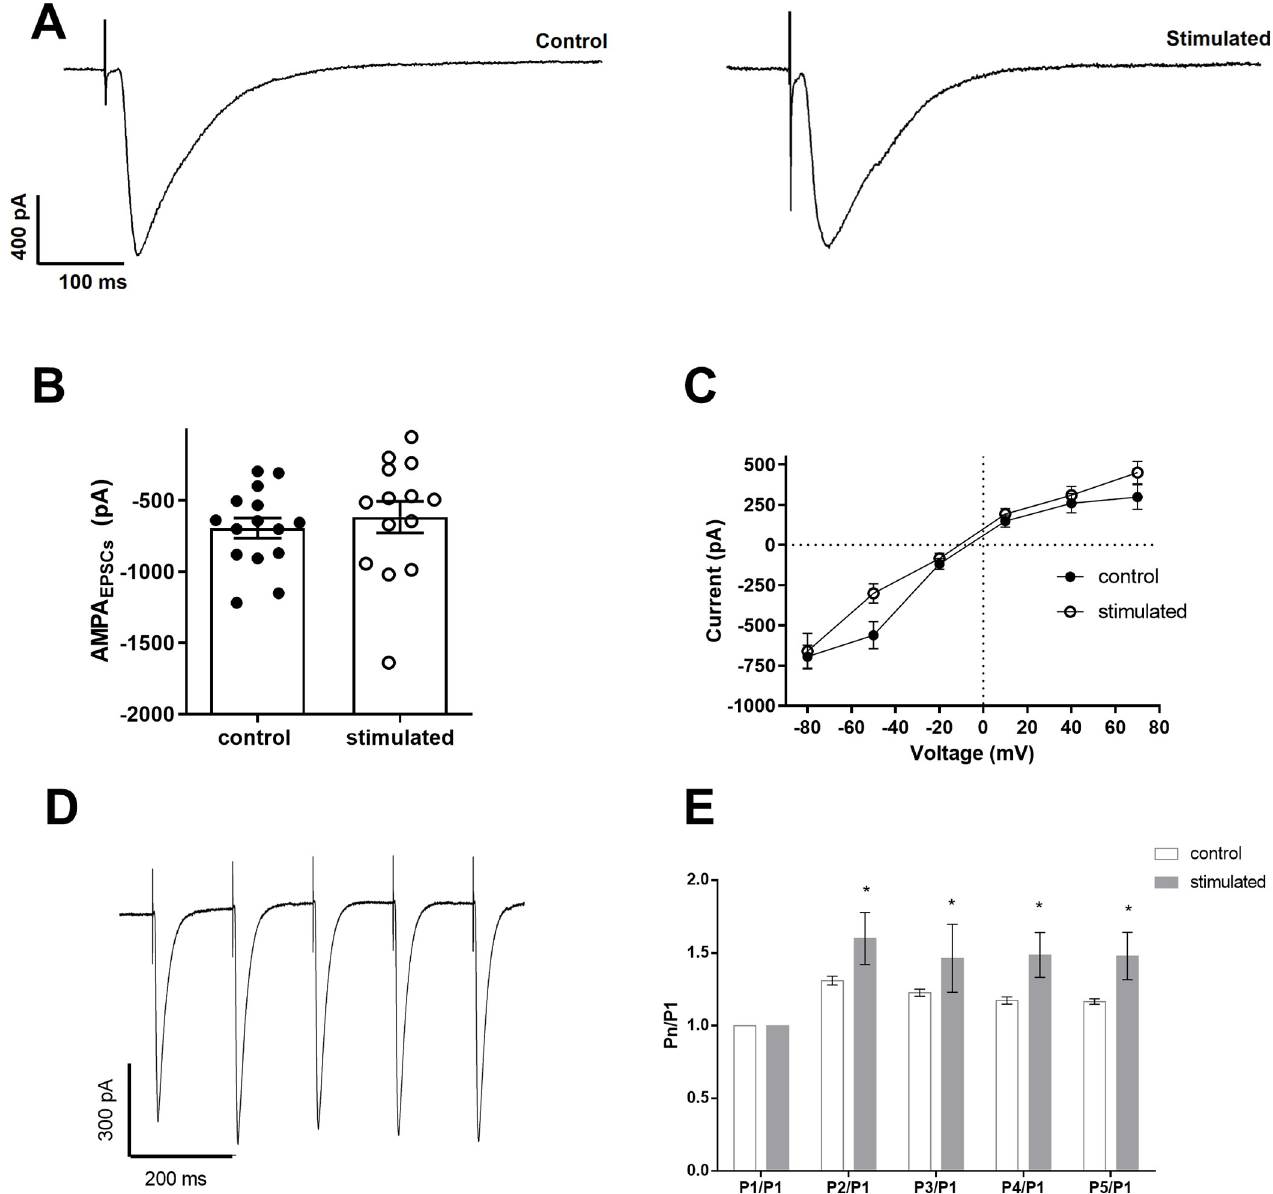
Fig 1. Evoked excitatory AMPA/KA post-synaptic currents (EPSCs) in CA1 pyramidal cells. A. EPSCs recorded in the presence of Picrotoxin (20 μ M) at -80 mV from control and stimulated animals. D. Mean AMPA/KA current amplitudes evoked at -80 mV. C. IV relationships for AMPA/KA currents. C. EPSCs in response to a 20 Hz train of stimuli. D. P1/Pn